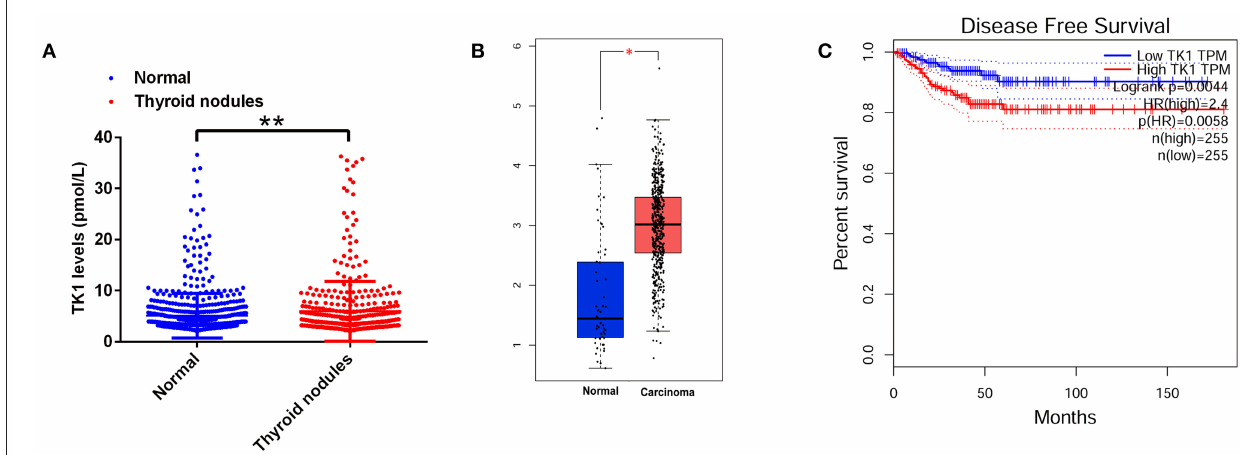
FIGURE 1 | Thymidine kinase 1 (TK1) was upregulated in patients with thyroid nodules and thyroid carcinoma. (A) The serum TK1 levels of normal subjects and subjects with thyroid nodules were detected by ELISA assay. (B) Online database [The Cancer Genome Atlas (TCGA)] analysis of the TK1 expression levels in the thyroid tissues from normal subjects and thyroid carcinoma patients. (C) The disease-free survival of the thyroid carcinoma patients as stratified by TK1 expression levels. * P < 0.05 and ** P < 0.01.